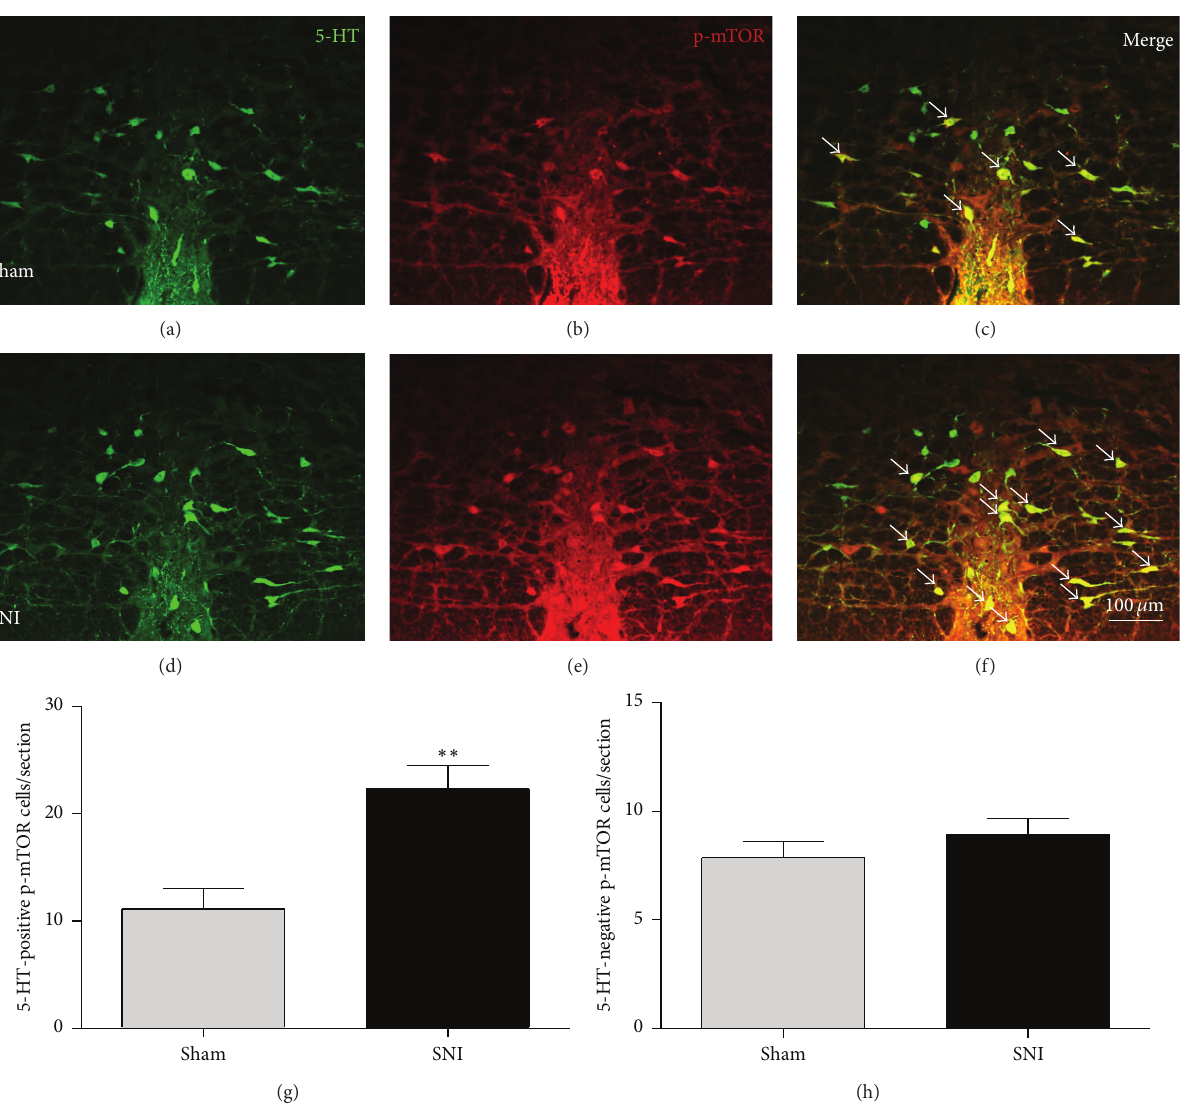
Figure 4: p-mTOR was mainly colocalized with 5-HTergic neurons in the RVM, and the number of 5-HT-positive p-mTOR neurons was significantly increased 7 days after SNI. (a)–(f) Representative fluorescence photomicrographs showing the expression of 5-HT (green) and p-mTOR (red) double-labeled neurons in the RVM in the sham control (a–c) versus the SNI 7-day group (d–f). Single arrows indicate p- mTOR/5-HT double-labeled (yellow) neurons. Scale bars = 100 𝜇 m. (g) The average number of 5-HT-positive p-mTOR neurons per section increased significantly in the SNI rats 7 days after surgery compared to the sham ( ∗∗ 𝑃 < 0.01 ). (h) In contrast, the average number of 5-HT- negative p-mTOR neurons did not change after SNI ( 𝑛 = 4